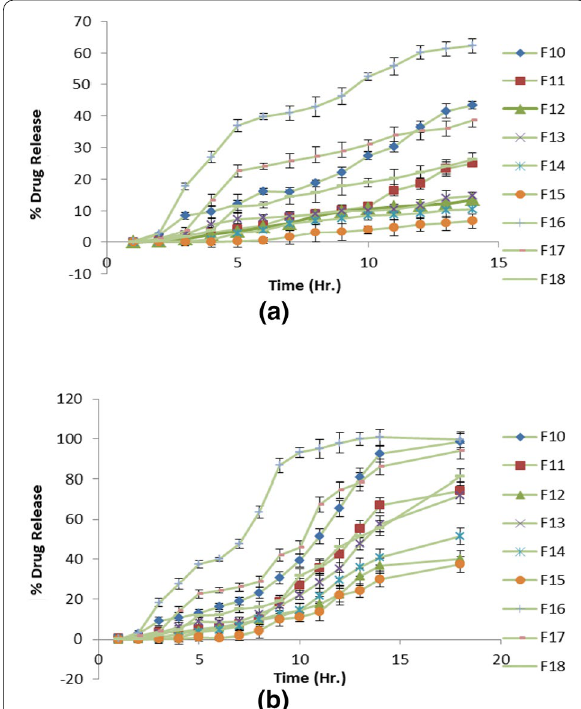
Fig. 2 Dissolution profiles of satranidazole pellets (Batch F10–F18) (Table 2) at a simulated gastrointestinal fluid (pH 1.2, pH 4.5 & pH 7.4) and b simulated colonic fluid (pH